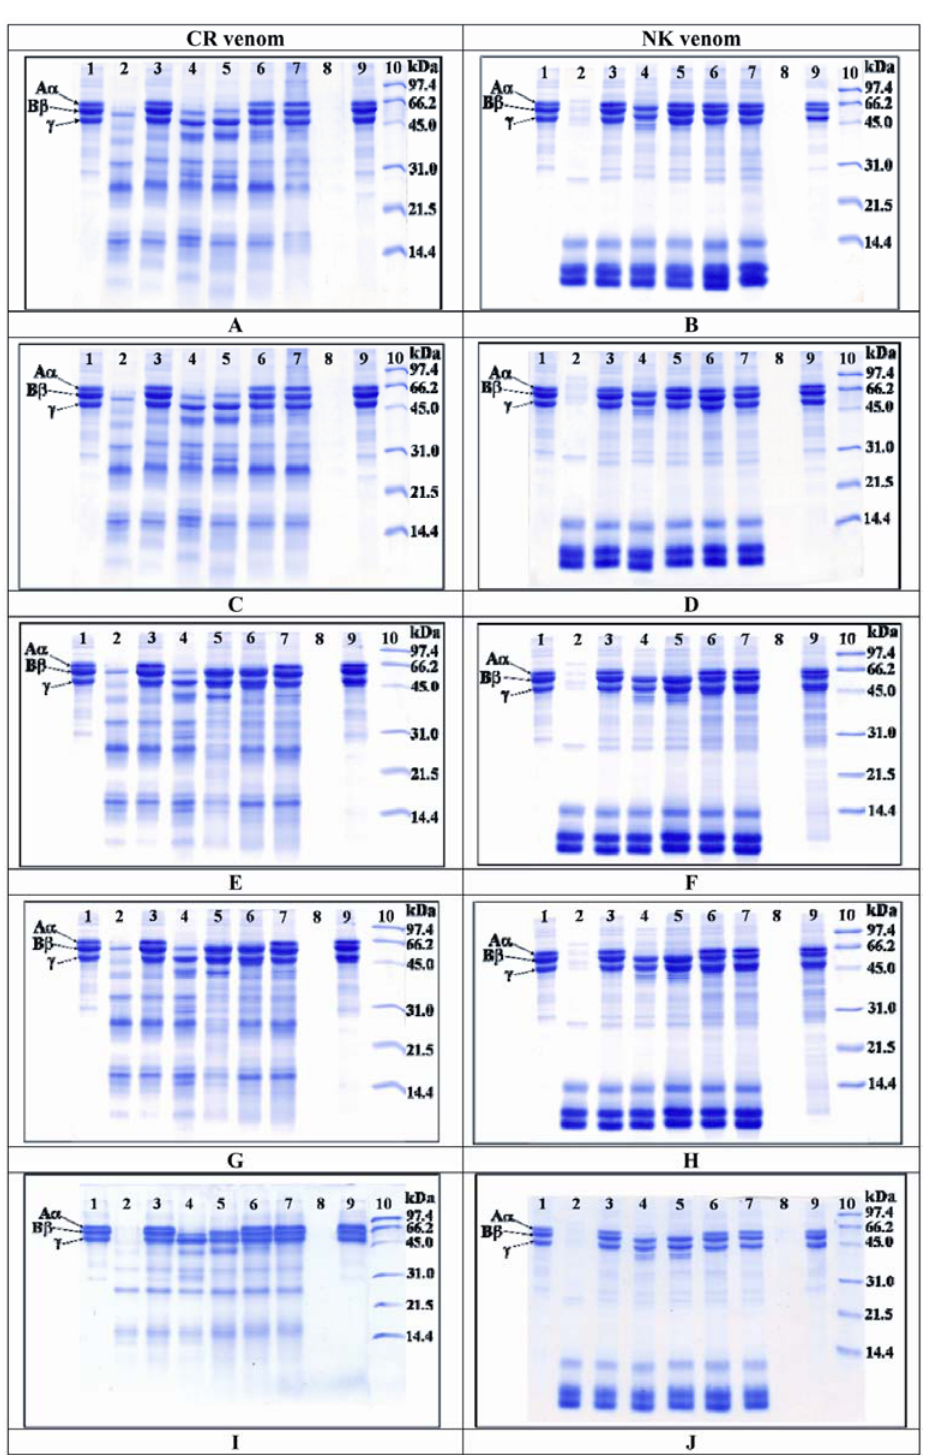
Figure 2. In vitro inhibition of fibrinogenolytic activity of CR (left) and NK (right) venoms by MSKE (A and B), PGG (C and D), MG (E and F), GA (G and H), and EDTA (I and